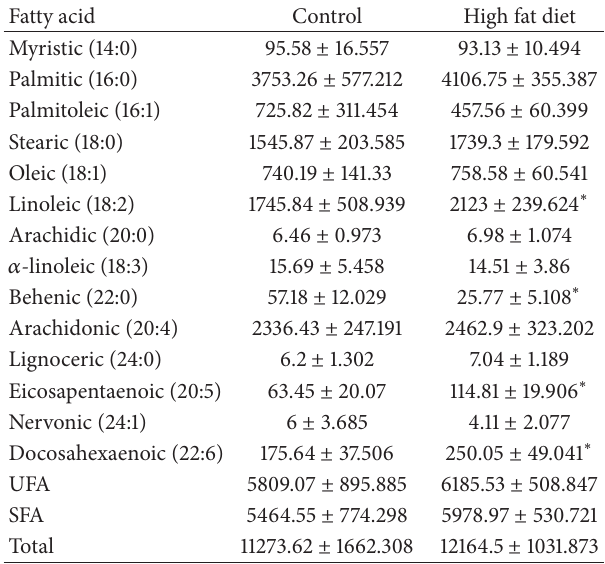
Table 6: Diacylglycerols composition in the parotid salivary glands (nmol/g).